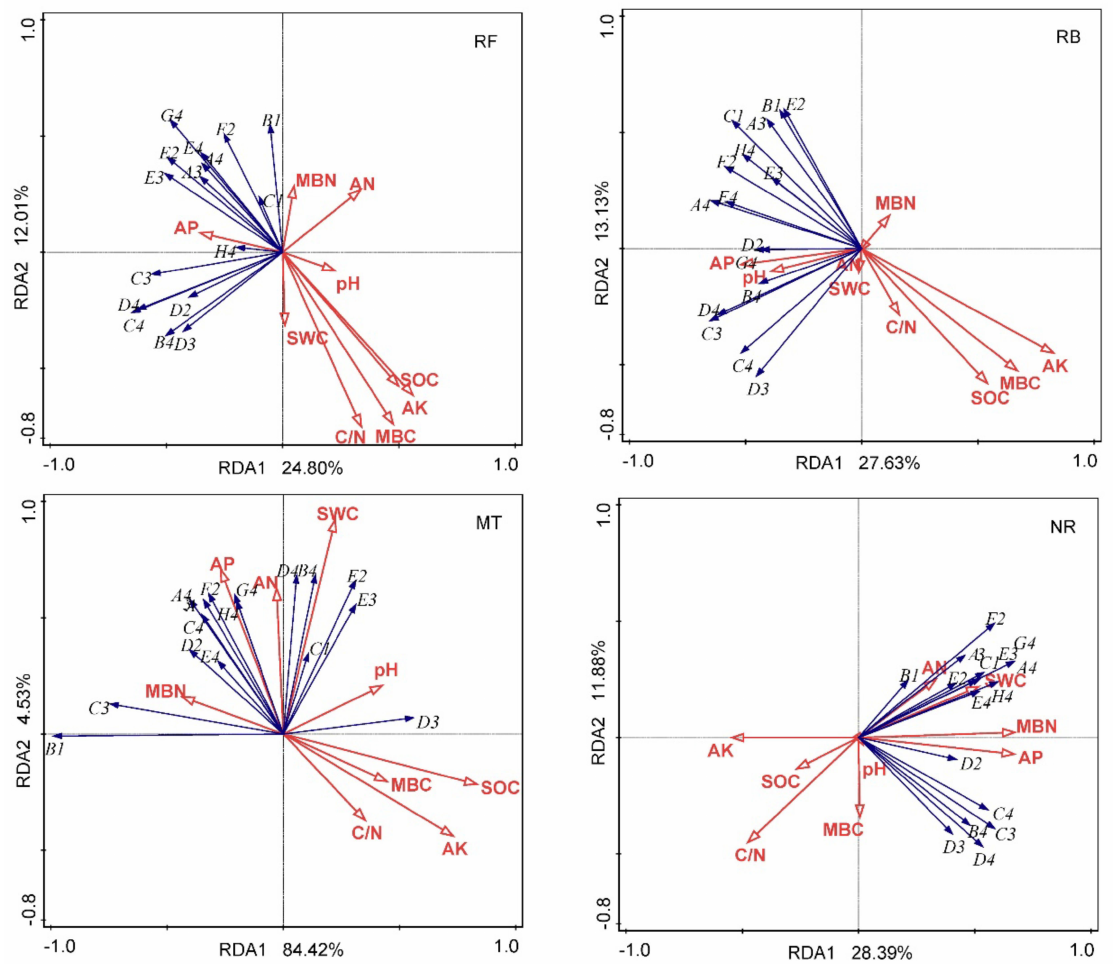
Figure 6. Double sequence diagram of the redundancy analysis in the soil microbial community constrained by soil data. AK, available potassium; AN, available nitrogen; AP, available phosphorus; MBC, microbial biomass carbon; MBN, microbial biomass nitrogen; C/N, MBC/MBN; pH, potential of hydrogen; SOC, soil organic carbon; and SWC, soil water content. Carbohydrates: D2 (D-mannitol), A3 (D-galactonic acid lactone), and E2 (N-acetyl-D-glucosamine); phenolic compounds: C3 (2- hydroxy benzoic acid), and D3 (4-hydroxy benzoic acid); polymers: C1 (Tween 40); carboxylic acids: E3 ( γ -hydroxy butyric acid), F2 (D-glucosaminic acid), and B1 (pyruvic acid methyl ester); amines: H4 (putrescine) and C4 (phenyl ethylamine); amino acids: A4 (L-arginine), E4 (L-threonine), D4 (L-serine), and G4 (L-phenylalanine), B4